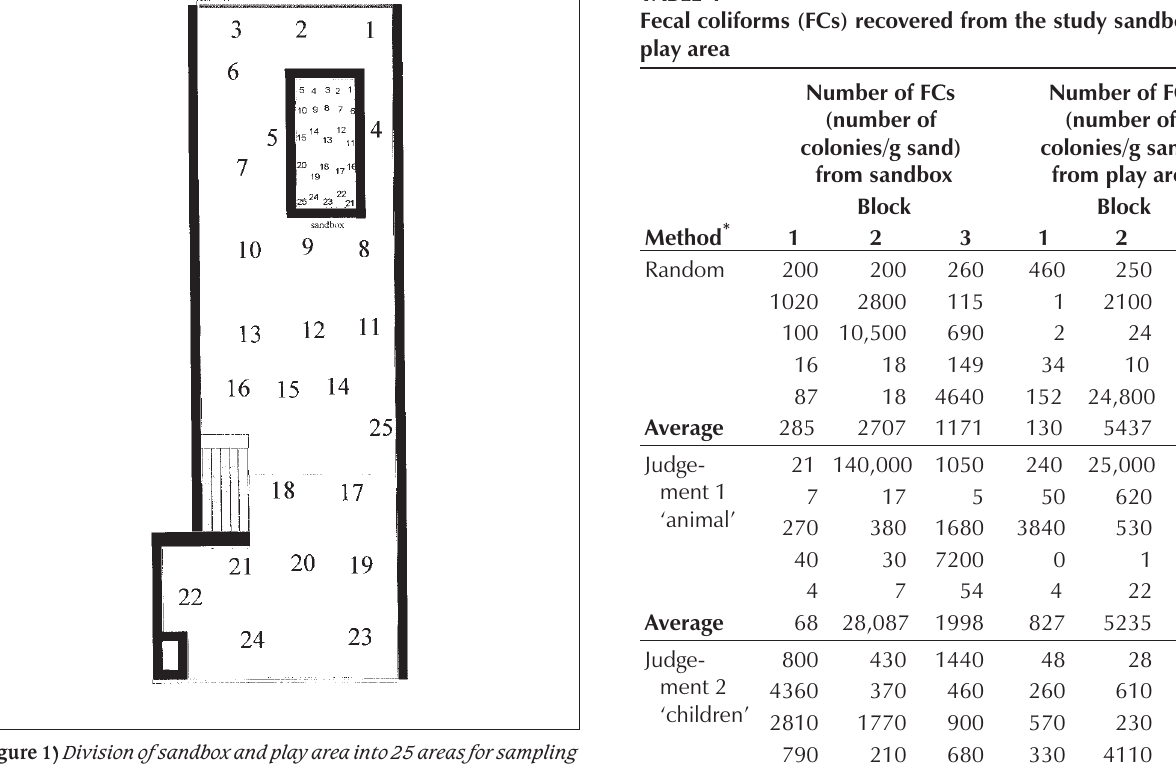
Fecal coliforms (FCs) recovered from the study sandbox